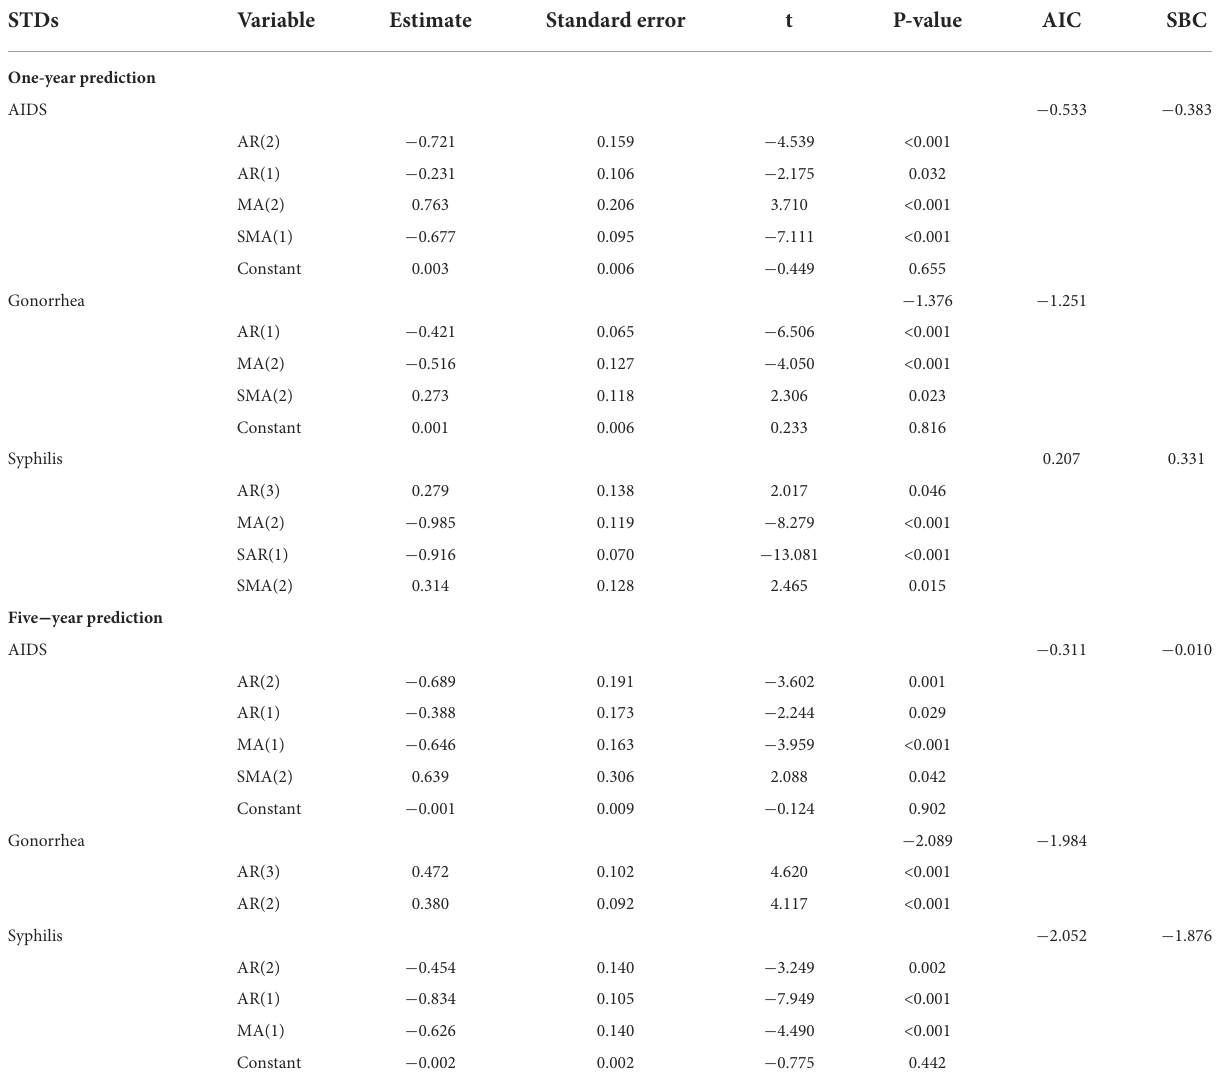
TABLE 2 Estimate parameters of the ARIMA models for STDs. STDs